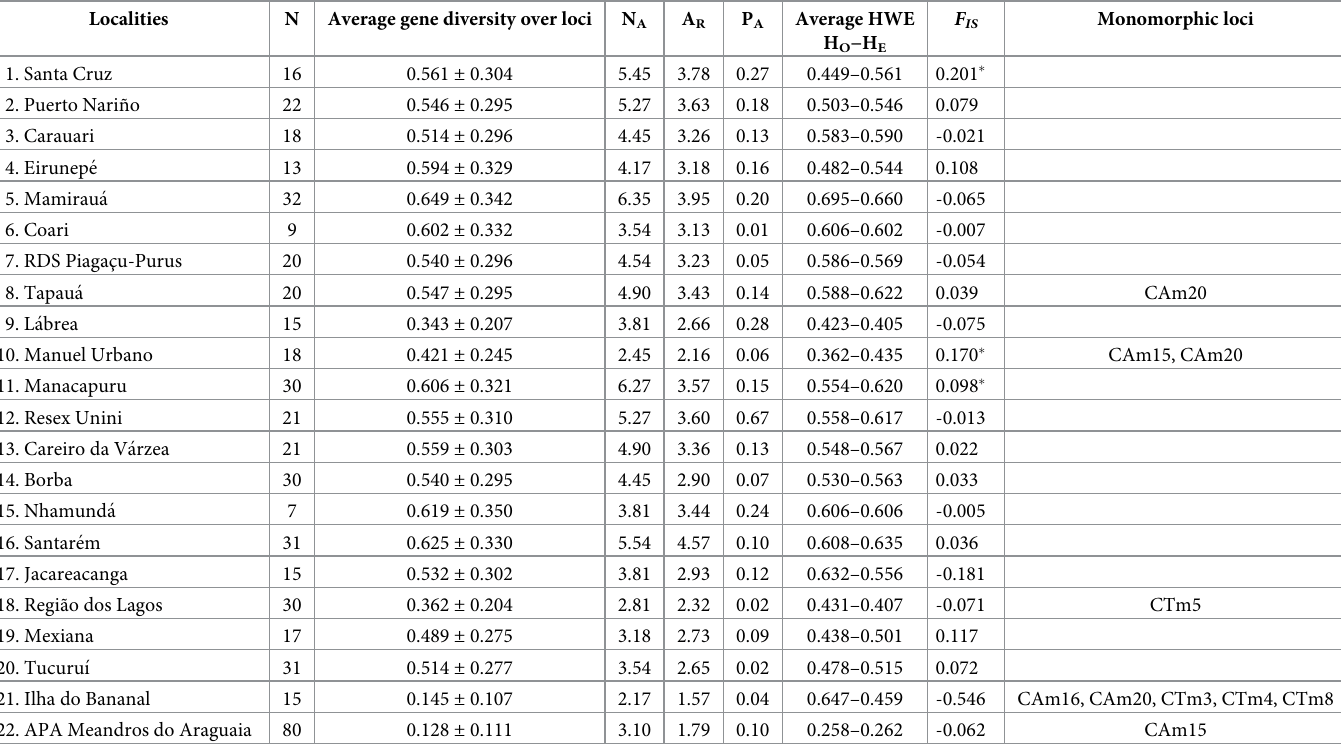
Table 2. Genetic characterization of Arapaima gigas sampled from 22 localities in Amazoˆnia.